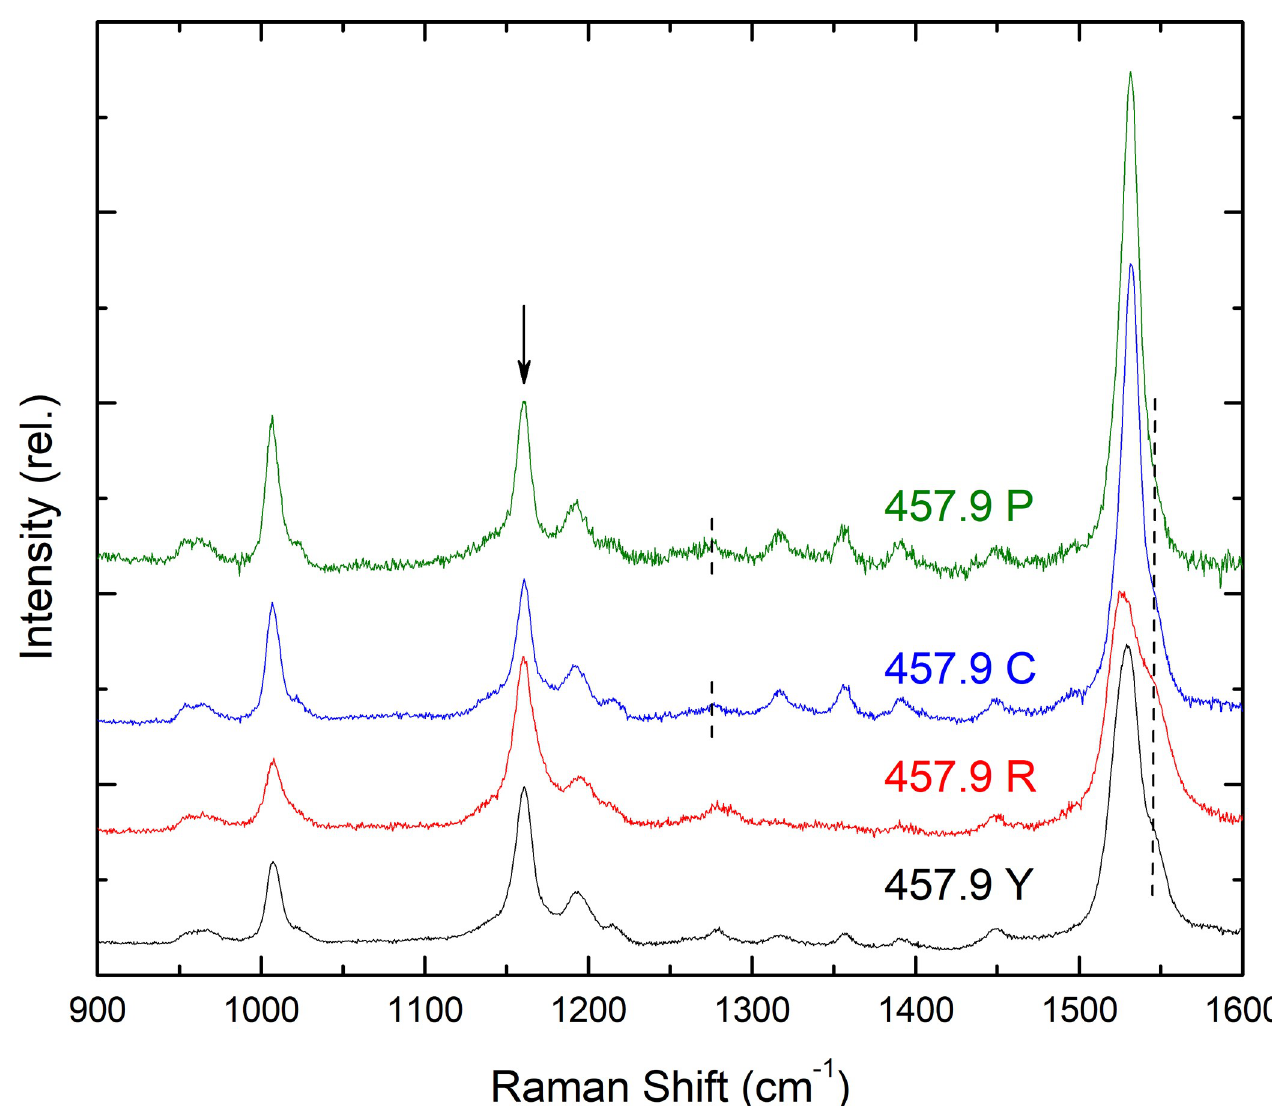
Fig 6. Resonance Raman spectra of all droplet types at 110 K, excited at 457.9